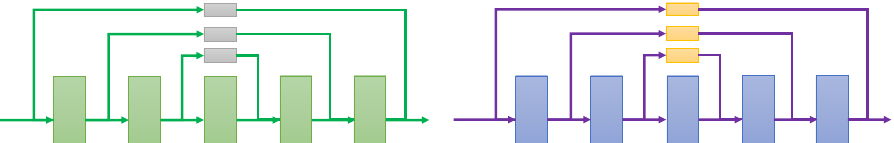
Figure 2. Backbone layers. The green boxes consist of a convolutional layer with a filter of 3 × 3, a Classification block (CB) Leaky ReLU layer, and a Dropout layer. The gray boxes consist of a convolutional layer with a